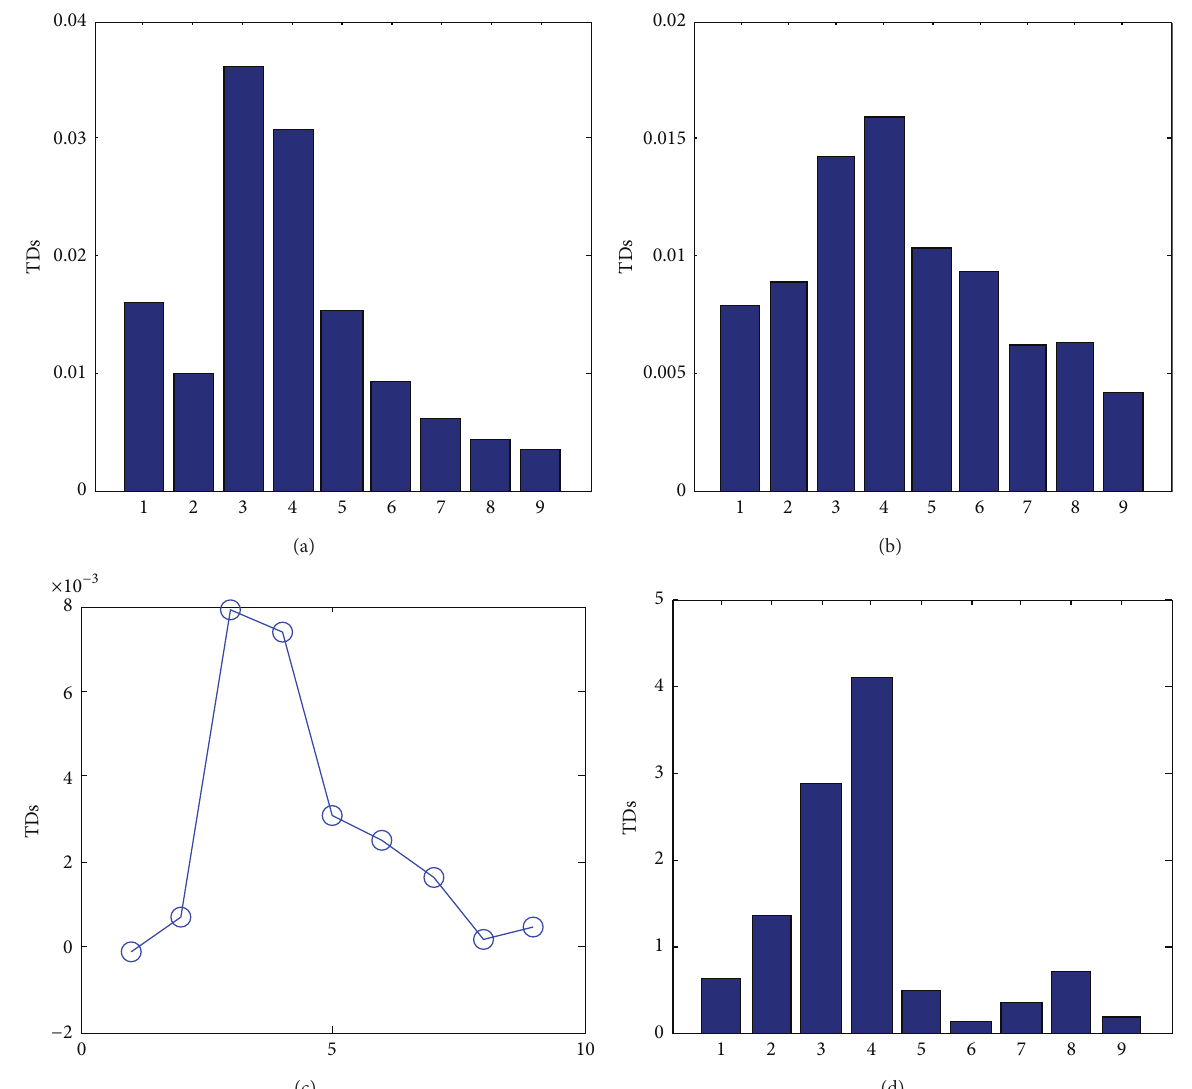
Figure 13: Detection indicators of the cantilever beam when 𝛾 = 0 . 2 for frequency band of 0–50 Hz with 60 dB: (a) this paper, (b) Schulz et al. [4], (c) magnitude value of Zhang et al. [6], and (d) Johnson and Adams [9].